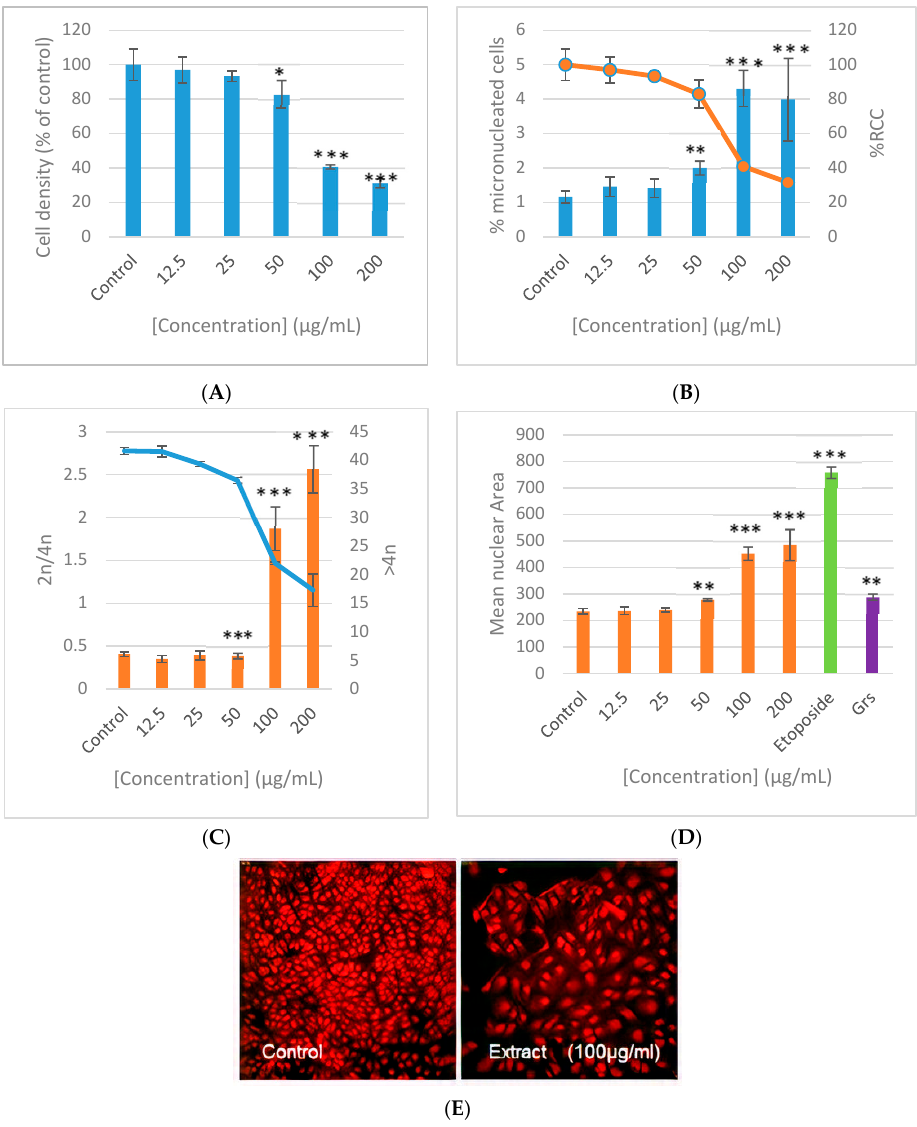
Figure 5. Micronucleus formation and nuclear parameters of Vero cells treated with different concentrations of H. petiolare methanol extract. Cytotoxicity is measured as decrease in the number of cells relative to the untreated control (also referred to as % Relative Cell Count). Data are expressed as the mean ± SD, n = 3. * p < 0.05, ** p < 0.01 and *** p < 0.001 compared to control. Griseofulvin (Grs). ( A ) Cytotoxicity; ( B ) micronucleus; ( C ) cell ploidy; ( D ) nuclear size; ( E ) micrographs (10× magnification) illustrating the nuclear size after treatment compared to the control.